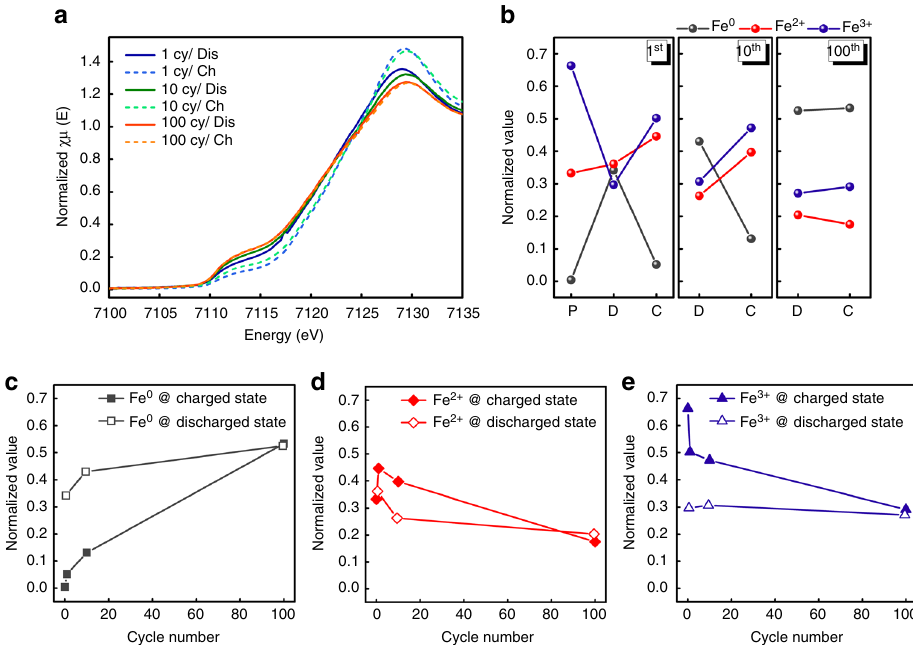
Fig. 2 Macroscopic phase evolution of Fe 3 O 4 at 1st, 10th, and 100th cycle. a XANES spectra of electrode materials at discharge and charge state of each cycle, respectively. b Quanti fi cation of the oxidation states of Fe at each state after 1, 10, and 100 cycles, where pristine, discharged, and charged states are represented with P, D, and C, respectively. c – e Quanti fi cation of each oxidation states of Fe at discharged and charged state as a function of cycle